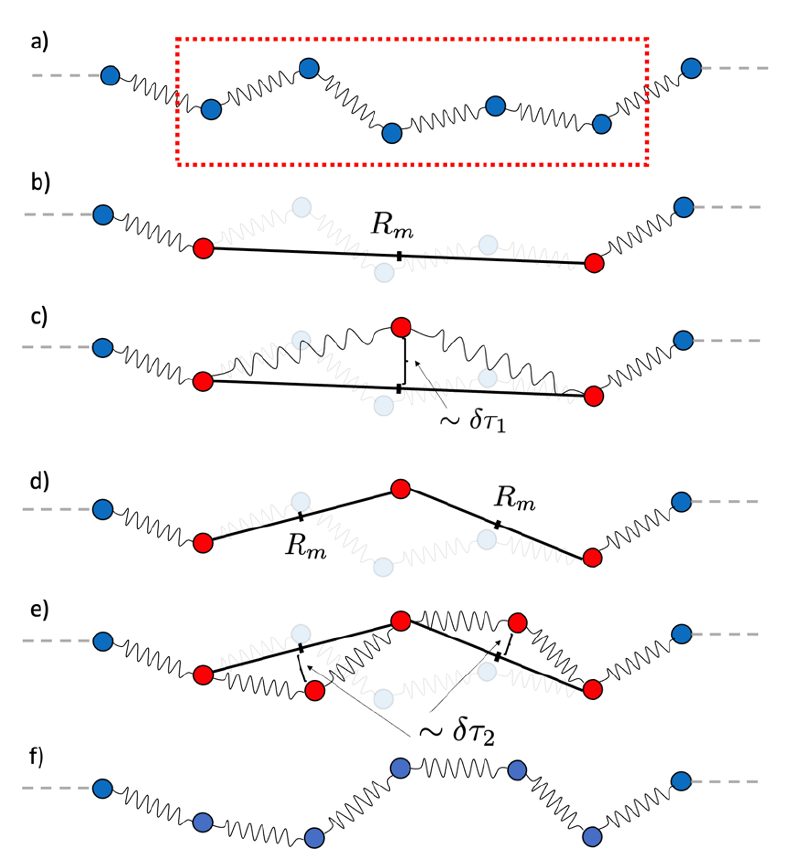
Figure 4: Visual representation of the bisection algorithm of level L = 2. a) A random slice of the open necklace with 2 L + 1 = 5 beads is selected. b) The endpoints